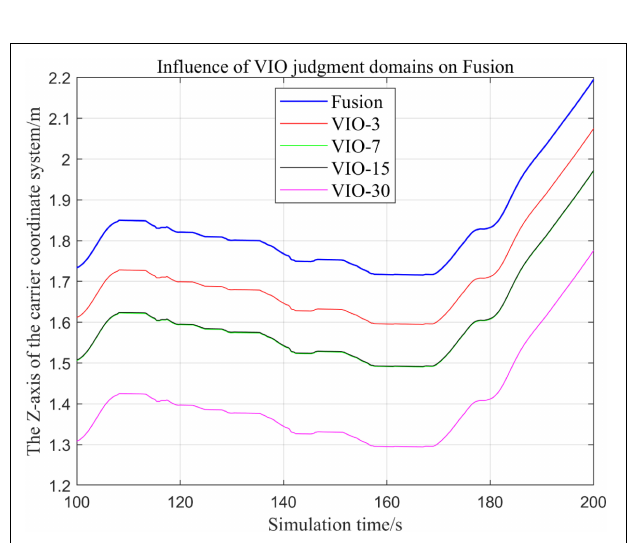
FIGURE 27 | Comparison of output z -axis local trajectories under different